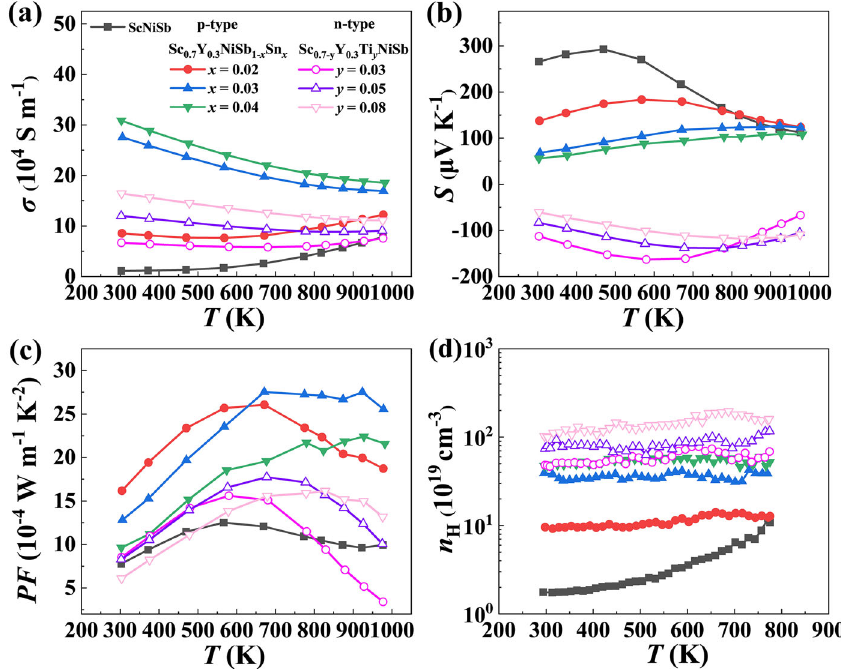
Fig. 5 Temperature-dependent electrical performance of ScNiSb, Sc 0.7 Y 0.3 NiSb 1 − x Sn x ( x = 0.02, 0.03, and 0.04) and Sc 0.7 − y Y 0.3 Ti y NiSb ( y = 0.03, 0.05, and 0.08). a Electrical conductivity. b Seebeck coef fi cient. c Power factor. d Hall carrier concentration.